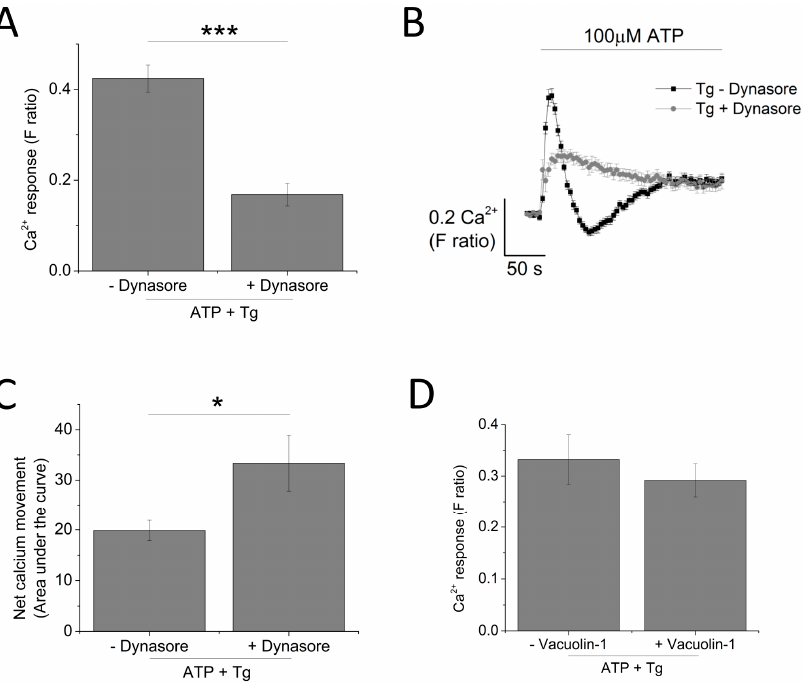
Figure 8. Targeting receptor trafficking to investigate contribution of P2X 4 receptor towards ATP-evoked Ca 2+ response in THP-1 differentiated macrophages. ( A – C ) effect of blocking endocytosis (80 μ M dynasore) on magnitude and net calcium movement ( n = 3) of Tg-resistant ATP-evoked Ca 2+ response; ( D ) effect of blocking lysosomal exocytosis (1 μ M vacuolin-1) on magnitude of Tg-resistant ATP-evoked Ca 2+ response ( n = 3). Asterisks include significant changes towards control (*** p < 0.001, * p < 0.05).